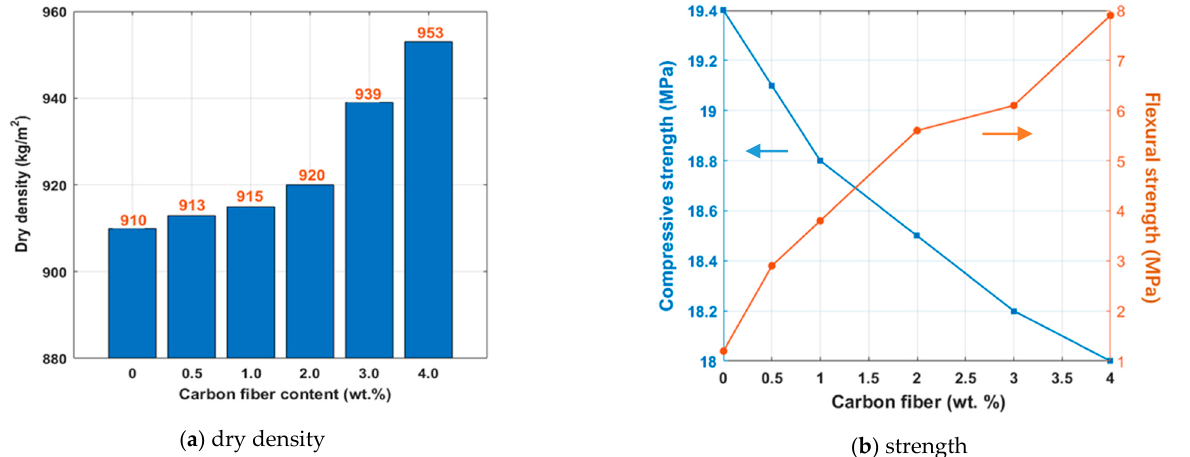
Figure 6. Physical properties of the contact-hardening composites with different carbon fiber contents: ( a ) dry density; ( b ) compressive and flexural strength.